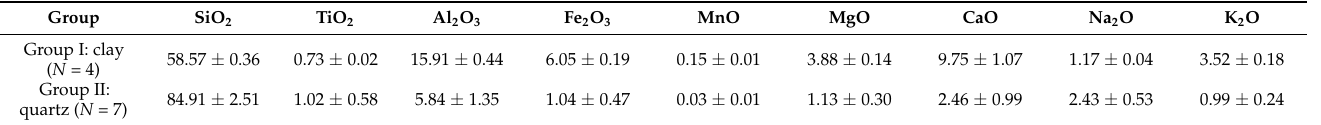
Table 2. Average compositions of the two chemical body groups based on the results from